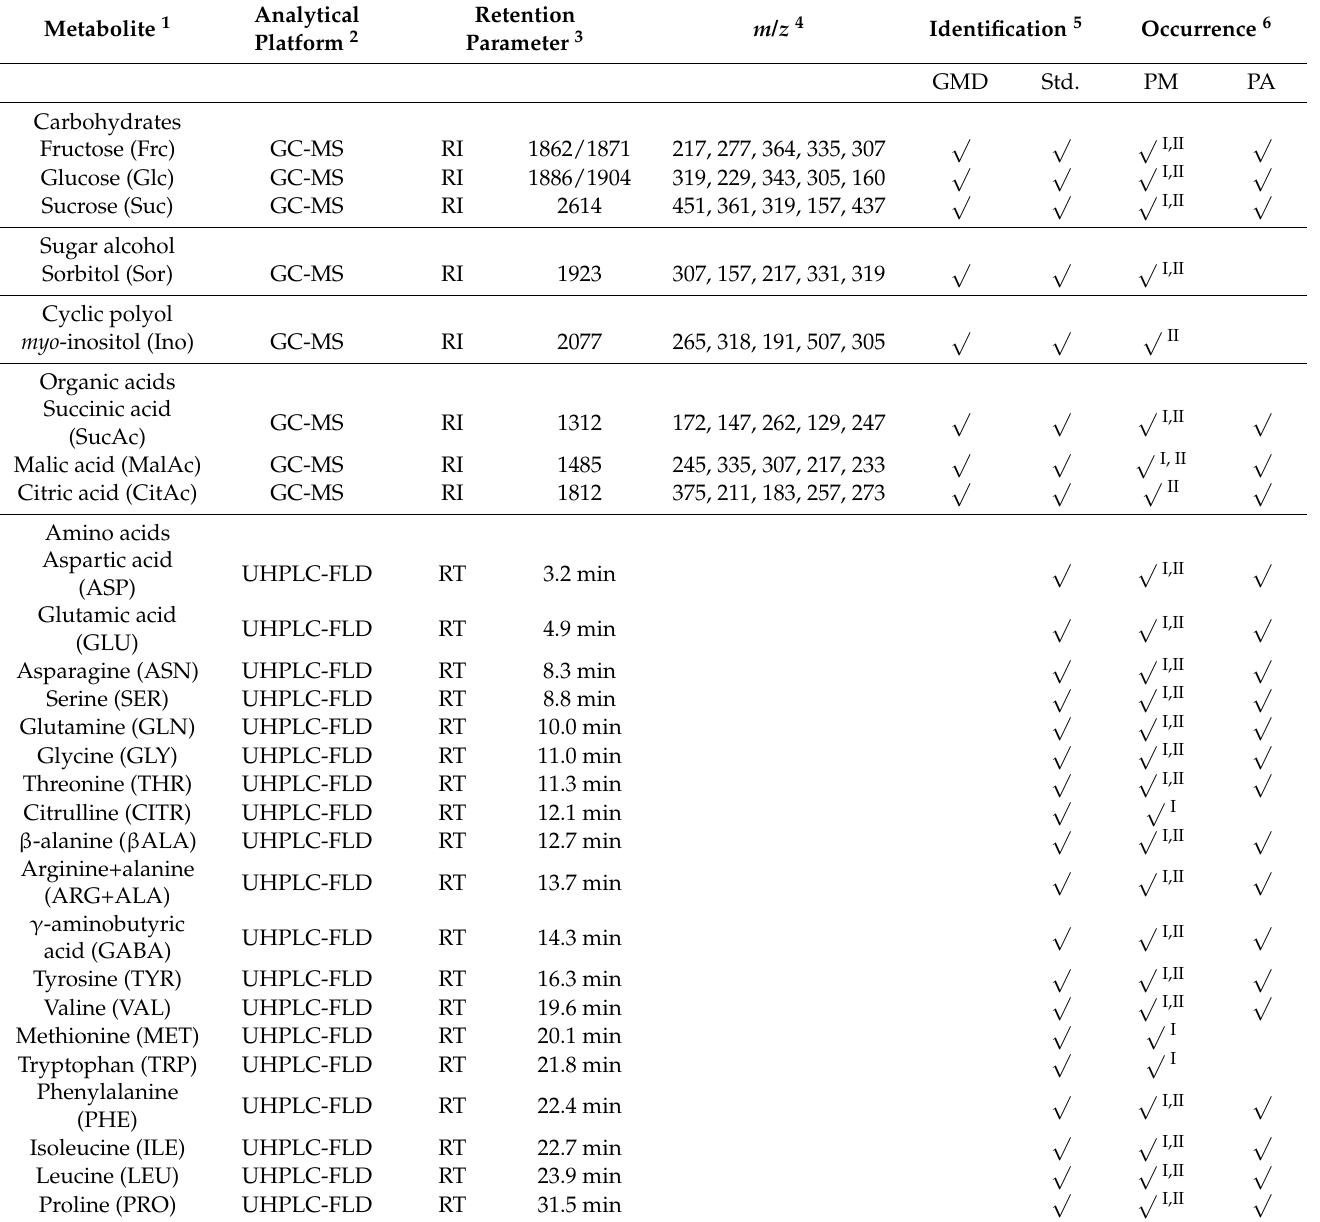
Table 1. Primary metabolites identified in phloem exudates of Plantago major (PM) and/or Poa annua